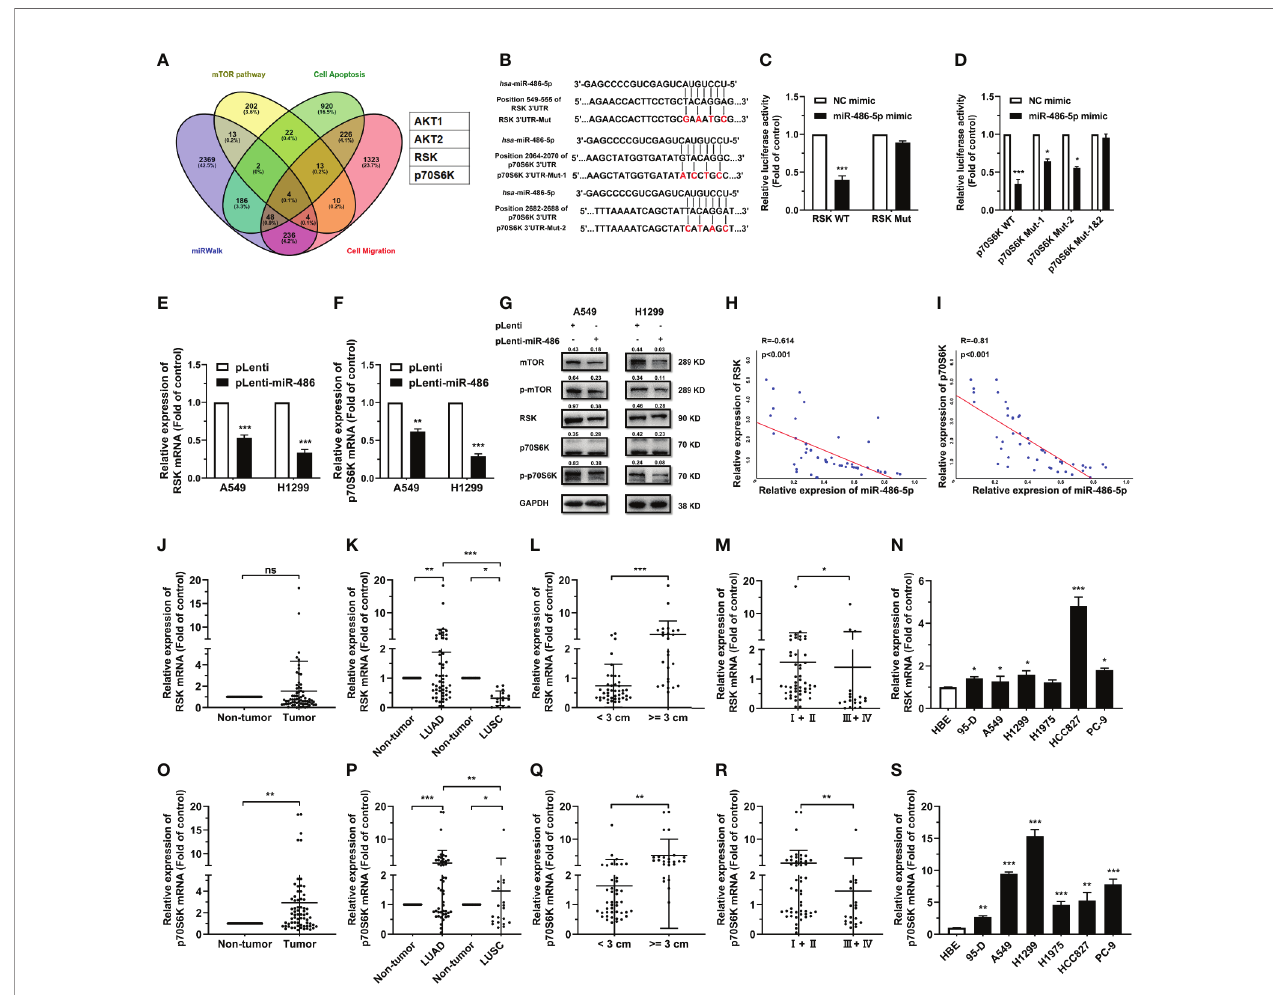
FIGURE 3 | miR-486-5p directly targets RSK and p70S6K. (A) The predicted targets of miR-486-5p by miRWalk 2.0. AKT1, AKT2, RSK and p70S6K stand out by restricting the results in the mTOR pathway, cell-apoptosis-associated proteins and cell-migration-associated proteins. (B) Schematic representation of the binding sites of miR-486-5p and the 3 ’ UTRs of RSK and p70S6K. (C, D) The luciferase activity in HEK293 cells cotransfected with, and RSK or p70S6K 3 ’ UTR, pRL vector (RSK/p70S6K WT), or with NC or miR-486-5p mimic, and the RSK/p70S6K 3 ’ mUTR, and pRL vector (RSK/p70S6K Mut). *p < 0.05; ***p < 0.001. (E – G) The mRNA (E, F) and protein (G) expression of RSK and p70S6K in pLenti/pLenti-miR-486 transfected A549 and H1299 cells. **p < 0.01; ***p < 0.001. (H, I) Correlation between miR-486-5p and RSK/p70S6K RNA expression in human LUAD tissue samples. Two-tailed Spearman ’ s correlation analysis. R, coef fi cient of association; P, p value. (J – M) The RNA expression of RSK in human NSCLC tissue samples (N=68). ns, non-signi fi cant. The expression between the LUAD (N=53) and LUSC (N=15) specimens. (K) , tissues with diameters < 3 cm (N=43) or >=3 cm (N=25). (L) , and TNM stage I/II (N=49) and stage III/IV (N=19). (M) samples was compared. *p < 0.05; **p < 0.01; ***p < 0.001. (N) The RNA expression of RSK in human NSCLC cell lines 95-D, A549, H1299, H1975, HCC827 and PC-9. HBE cells were used as normal control. *p < 0.05; ***p < 0.001. (O, R) The RNA expression of p70S6K in human NSCLC tissue samples (N=68). The expression between the LUAD (N=53) and LUSC (N=15) specimens. (P) , tissues with diameters < 3 cm (N=43) or >=3 cm (N=25). (Q) , and TNM stage I/II (N=49) and stage III/IV (N=19). (R) samples was compared. *p < 0.05; **p < 0.01; ***p < 0.001. (S) The expression of p70S6K RNA in human NSCLC cell lines 95-D, A549, H1299, H1975, HCC827 and PC-9. HBE cells were used as normal control. *p < 0.05; **p < 0.01; ***p <